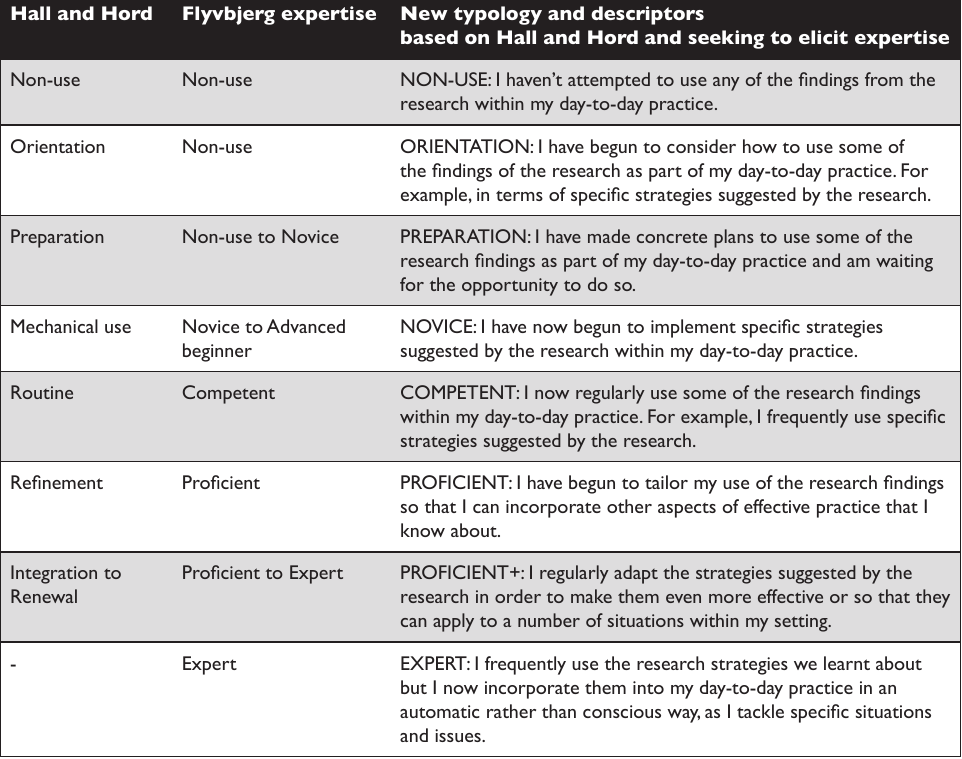
Figure 2: Typologies and descriptors of expertise Hall and